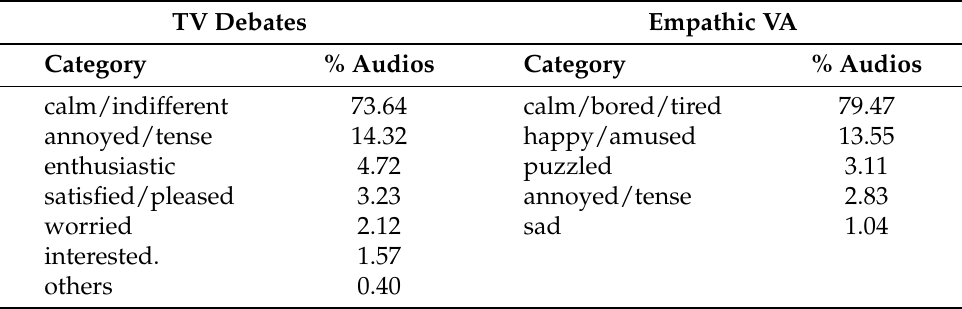
Table 5. Frequency of the different categories in the corpora. Both the TV Debates and Em- pathic VA datasets are unbalanced. The majority class is the neutral emotion (calm/indifferent and calm/bored/tired), with more than 70% of the